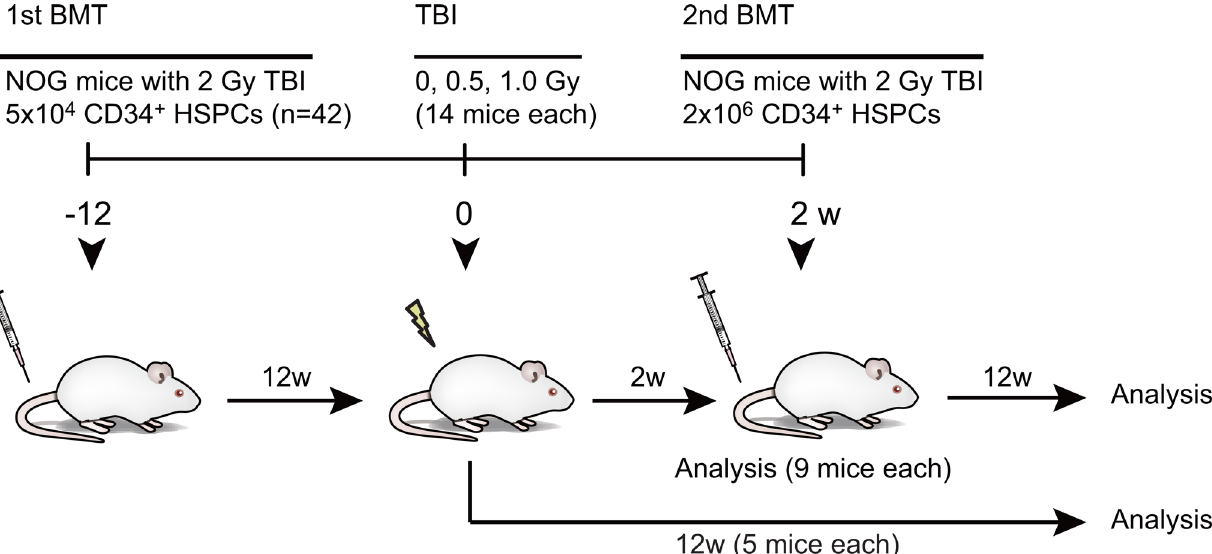
Fig 1. Experimental design to detect the non-lethal radiation effects on human HSPCs in vivo . Schema of experimental strategy. Cord blood CD34 + HSPCs (5 x 10 4 ) were transplanted via tail veins into 8-week-old NOG mice irradiated with 2.0 Gy (n = 42). In the twelfth week after transplantation, the mice were randomly grouped into three categories and irradiated with 0, 0.5 or 1.0 Gy for each group (14 mice each). At 2 weeks post-irradiation, part of the mice (9 mice each) were sacrificed to evaluate early effects of irradiation. At the same time, human CD34 + HSPCs were purified from the primary recipient mice (9 mice were pooled), and 2 x 10 6 CD34 + HSPCs were transplanted into the secondary NOG recipients. At 12 weeks post-secondary transplantation, mice were sacrificed to evaluate long-lasting effects of irradiation. The remaining primary recipient mice (5 mice each) were similarly analyzed at 12 weeks post- irradiation to evaluate long-lasting effects of